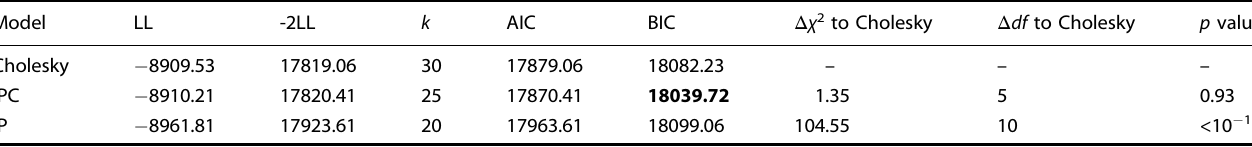
Table 3. Multi-domain GSEM model fi t comparisons of passage reading subset.